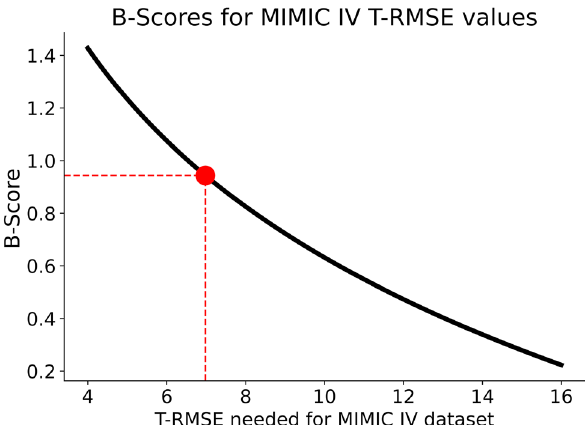
Figure 7. B-Scores calculated for various systolic MIMIC IV T-RMSE values (black line). The red dot indicates the T-RMSE which reaches a coequal performance to the device proposed by Patzak et al. The red dashed lines indicate the B-Score (0.96) and T-RMSE (6.98) of coequality.